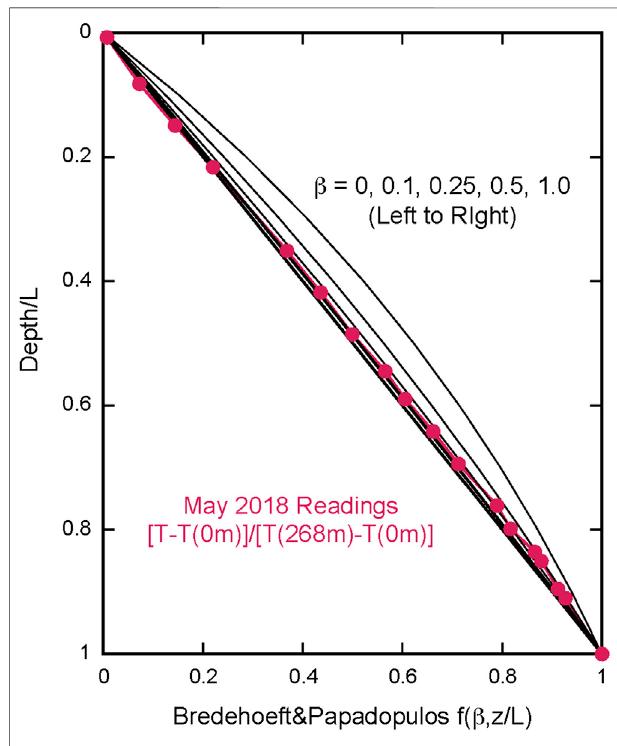
FIGURE 7 | Non-dimensionalized May 2018 thermistor cable readings plottedagainsttheBredehoeftandPapadopulos(1965)f( β ,z/L)functionalong with characteristic type curves values for values of β associated with upward migration of pore- fl uids. As detailed in the text, the consistency of the temperature data with the type curve for β (cid:2) 0.1 suggests an upward pore- fl uid migration rate no greater than ∼ 10 − 10 m/s.